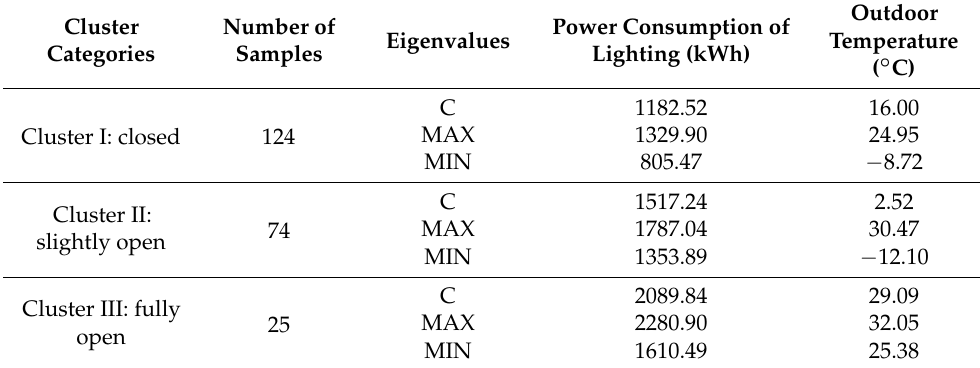
Table 8. Detailed information of the samples for a whole year by KNN method.